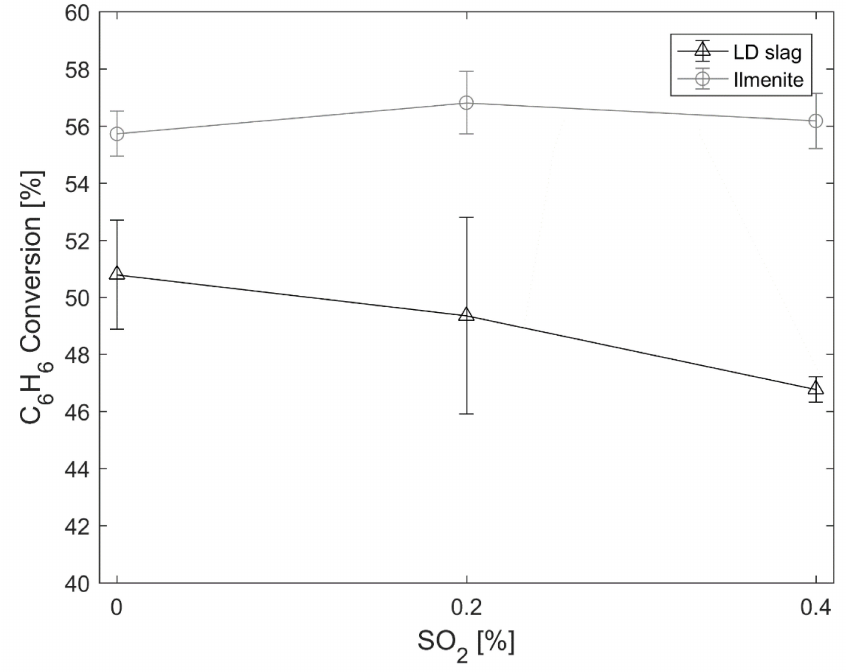
Figure 12. Benzene conversion at 850 ◦ C using LD slag and ilmenite in the presence of SO 2 . Note that the scale of conversion is only between 40% and 60%. See Table 4 for experimental conditions during the reducing